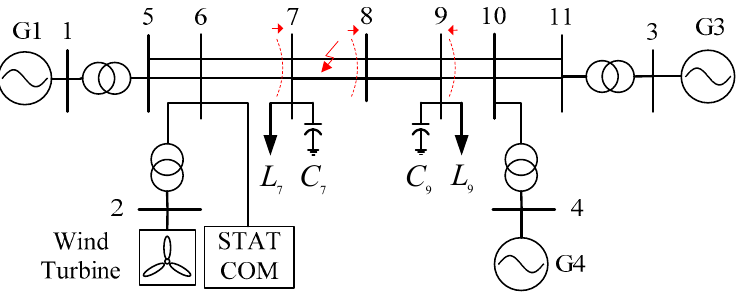
Figure 7. Schematic diagram of modified Kundur’s two-area system. Table 1. Information of modified Kundur’s two-area system.